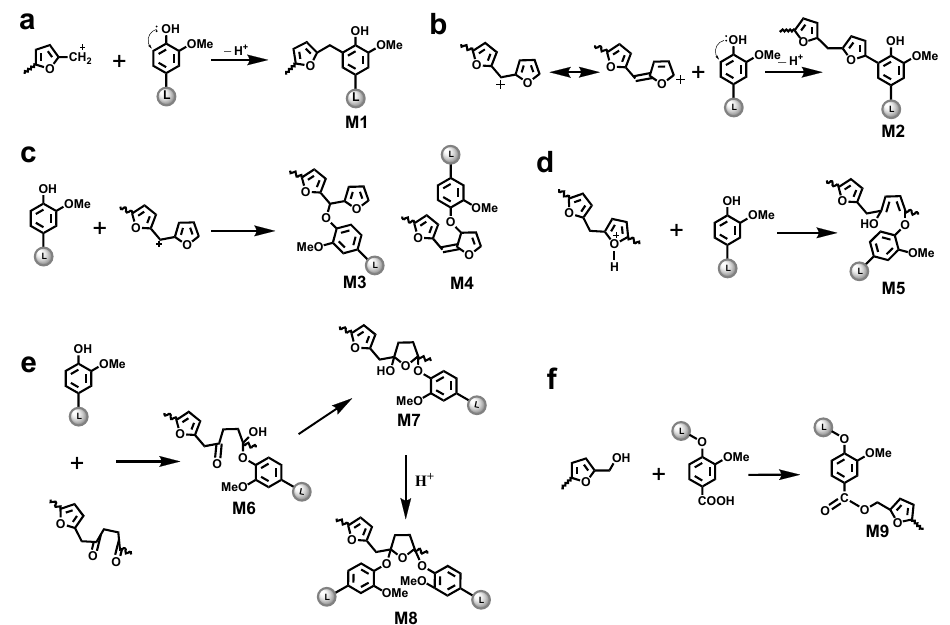
Figure 5. Hypothesized reaction between furfuryl alcohol and lignin (see text for details). Different types of lignin hydroxyl groups as well as carboxylic groups were quantified by 31 P NMR spectroscopy after phosphitylation (Figure 6). The amounts of aliphatic OH groups dramatically increased due to the contribution of pFA moieties. However, it could be assumed that the resonance in phenolic OH groups belong exclusively to lignin. As the amounts of lignin in LFA fractions were different, it is difficult to compare the amount of PhOH directly. However, the ratio between condensed (at 5-position) and non-condensed PhOH increased in the order KL > LFA-I > LFA-S, indicating participation of the o -position (5) in condensation reactions during resin formulation. This was mainly caused by the formation of new condensed phenolic moieties resonating at 141.8 ppm (Figure 6). Their amount was much higher in LFA-S as compared to LFA-I. It could not belong to the structure M1 as it was not detected in the HSQC spectrum of LFA-S. Therefore, the resonance at 141.8 ppm should be originated from other types of 5-condensed structures. For example, a condensed structure M2, where a free phenolic guaiacyl unit is directly connected to a terminal furan ring in pFA, was proposed in Figure 5b. At the first step of this reaction, a carbonium ion located at the 5-position of a terminal furan ring of pFA is formed from an intermediate produced, according to the mechanism shown in Figure 1c through a conjugated double-bond sequence. However, structure M2 does not give any characteristic cross-peak in the HSQC spectrum and therefore cannot be confirmed by this technique.